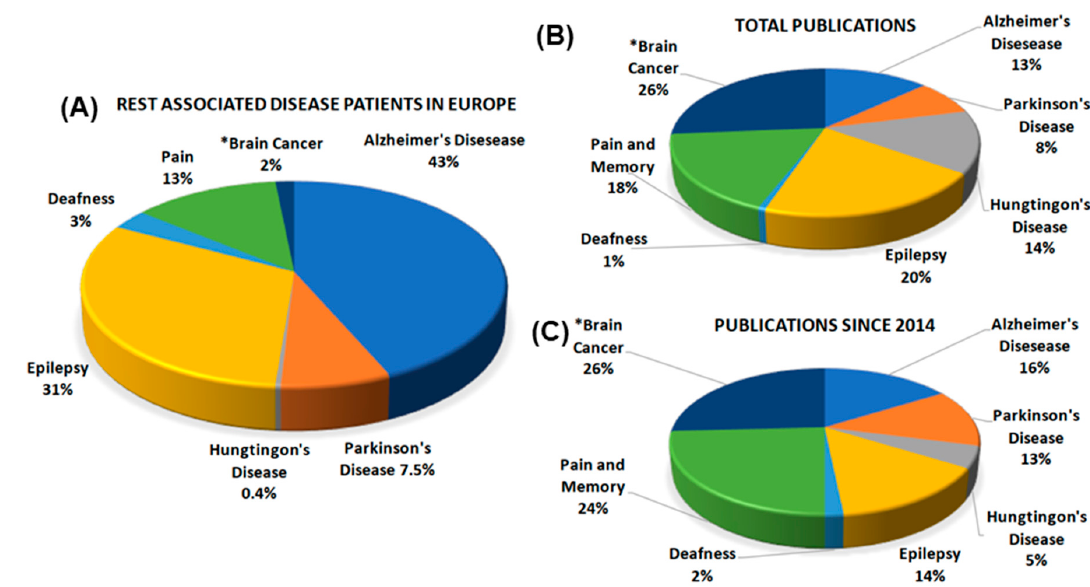
Figure 2. Pie Charts illustrating the patients of several brain diseases and their publications. Chart ( A ) illustrates the expression and the distribution in Europe of the patients affected by brain diseases that previous studies have reported affected by REST (REST-associated diseases). The patients of the various diseases are presented here as fractions of the 100% of Pie Chart. Among neurodegenerative diseases, Alzheimer’s accounts for 43% (=7 million), Parkinson’s for 7.8% (=1.2 million), Huntington’s for 0.4% (=62,000) of total patients (Data from the EBC Consensus Documents on European Brain Research). The additional slices illustrate the expression of other REST-associated diseases: epilepsy (31% = 5 millions); pain and memory (13% = 2 millions); and genetic deafness (3% = 0.4 millions) (Data from Epilepsy out of the Shadows). Brain cancers, accounting for 2% of the patients, have been estimated from the data of the National Cancer Institute of the USA (https://seer.cancer.gov/statfacts/html/brain.html), recalculated for the European population [29]. Pie Chart ( B ) illustrates the total publications of the same diseases, expressed in terms of percentages as in Chart ( A ); Pie Chart ( C ) to the publication of the same diseases appeared during the last 5 years. Notice the differences between the publication data of Charts ( B , C ) with respect to the patient data of Chart ( A ). Major such differences are those of cancers (2% patients accounting for over 25% of the publications in both ( B , C )) and Huntington’s (from 0.4% to the 14 and 5% of publications). On the other hand, 43% Alzheimer’s patients correspond to only 13–16% of publications. Distinct differences, present between total and recent publications (charts B , C ), are visible for Parkinson’s and deafness that increase from 8% to 13% and from 1% to 2%. In contrast, the B to C changes of Huntington’s and epilepsy do not increase but decrease: from 14% to 5% and from 20% to 14%, respectively.